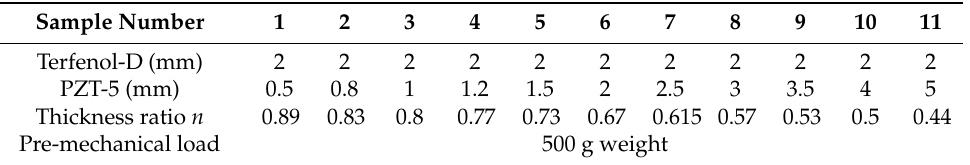
Table 2. The configuration of ME laminate sample under 500 g weight mechanical load.